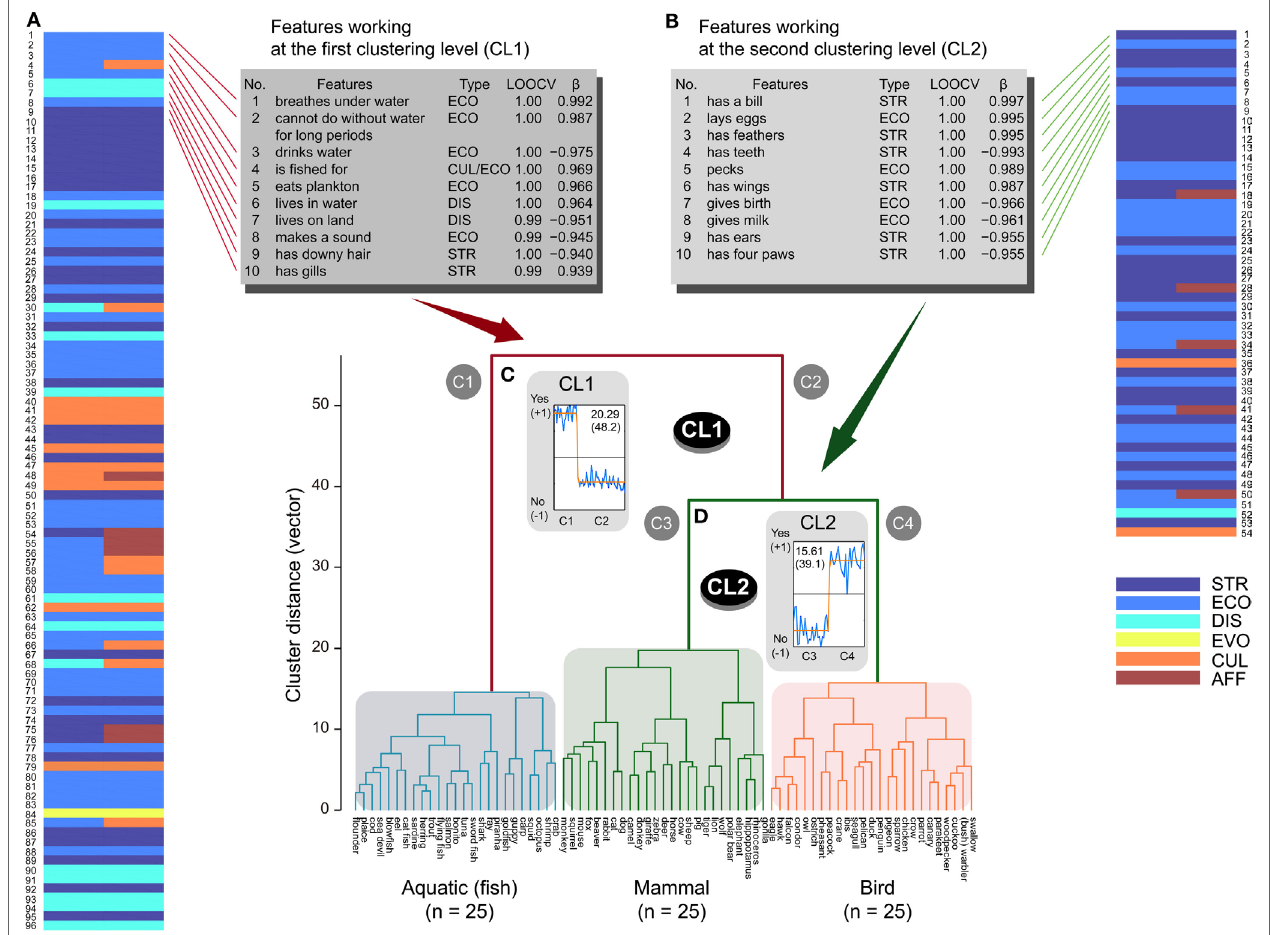
FigUre 2 | Super-ordinate animal classification ( n = 75) in the three super-ordinate classes and related features ranked within the top 10. The 75 animals were clustered into the two clusters related to aquatic (C1) and terrestrial (C2) categories at the first clustering level (CL1). The terrestrial cluster was separated into two clusters belonging to the mammal (C3) and bird (C4) classes at the second clustering level (CL2). Distinguishing features ranked within the top 10 are listed for CL1 and CL2 (STR, structural; ECO, ecological; DIS, distributional; EVO, evolutional; CUL, cultural; AFF, affective) from significant features represented by colored brick charts. These features possessed high-classification accuracies during the leave-one-out cross-validation (LOOCV) tests and good fitting properties ( β ) to sigmoid shape functions for CL1 (a) and CL2 (B) , respectively. Higher scores on the LOOCVs indicate higher classification accuracy, and more positive and larger β coefficients represent better fitting